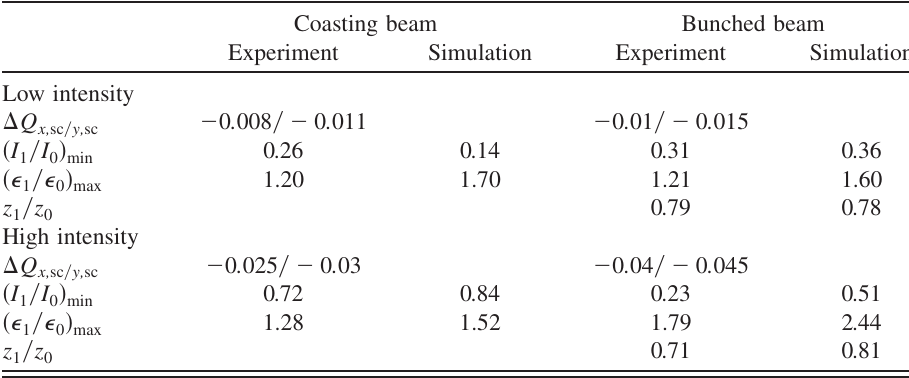
TABLE III. In this table we compare the key quantities reported in Table II with the correspondent values found from simulations. The numerical predictions on beam loss are acceptably close to the measured value. Only the emittance growth from simulations for the case of a bunched beam at high intensity exceeds significantly the measured one. This is attributed to the limits of the numerical model of the SIS18 which is an approximation of the real synchrotron. The uncertainties in these parameters are the same as those in Figs. 6, 8, 13, and 14.